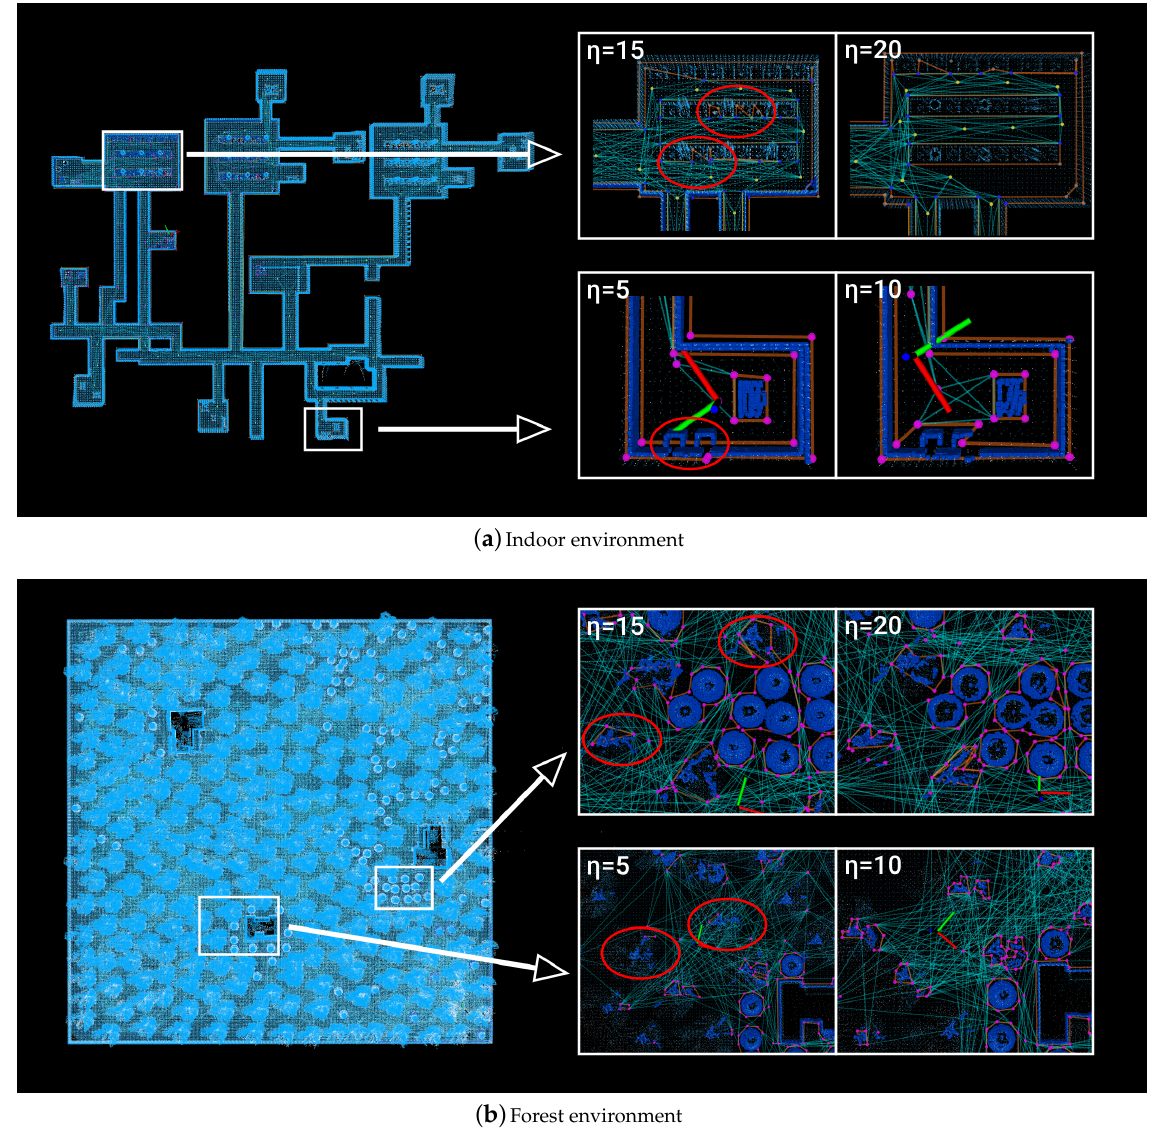
Figure 17. Different η in the indoor and forest